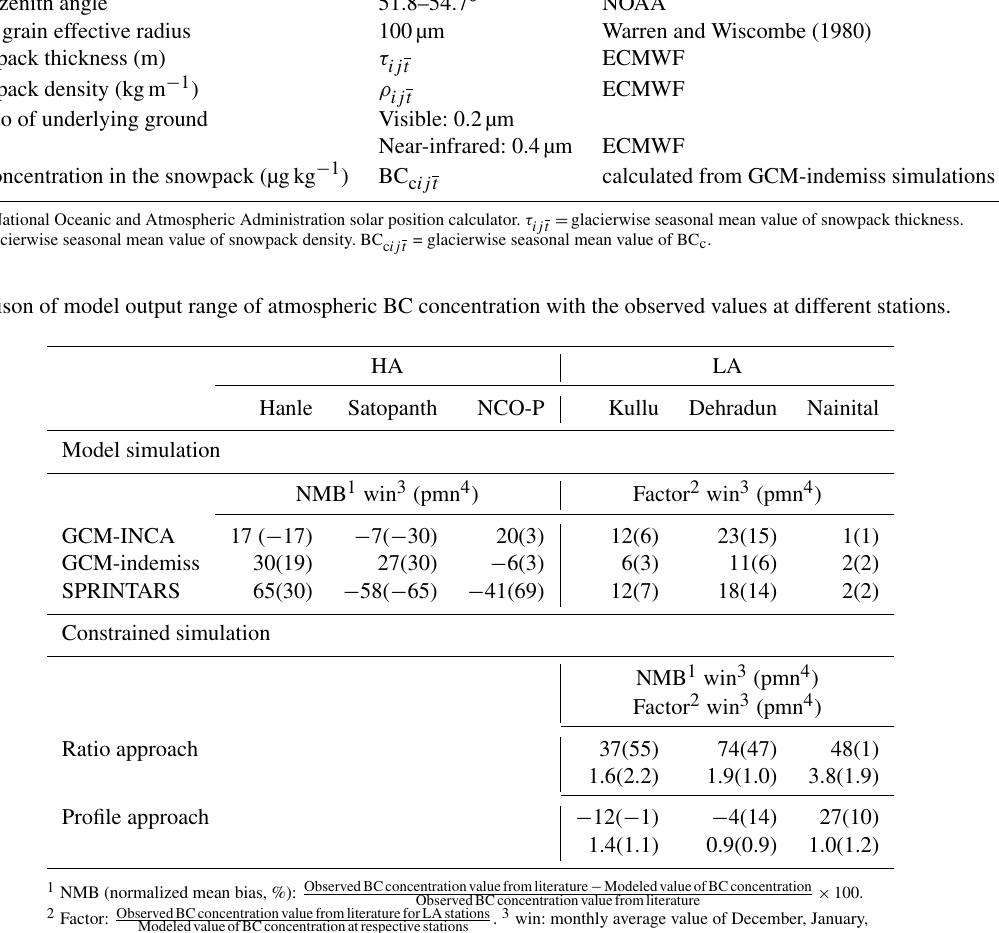
Table 3. Input parameters for SNICAR-Online model. Parameters